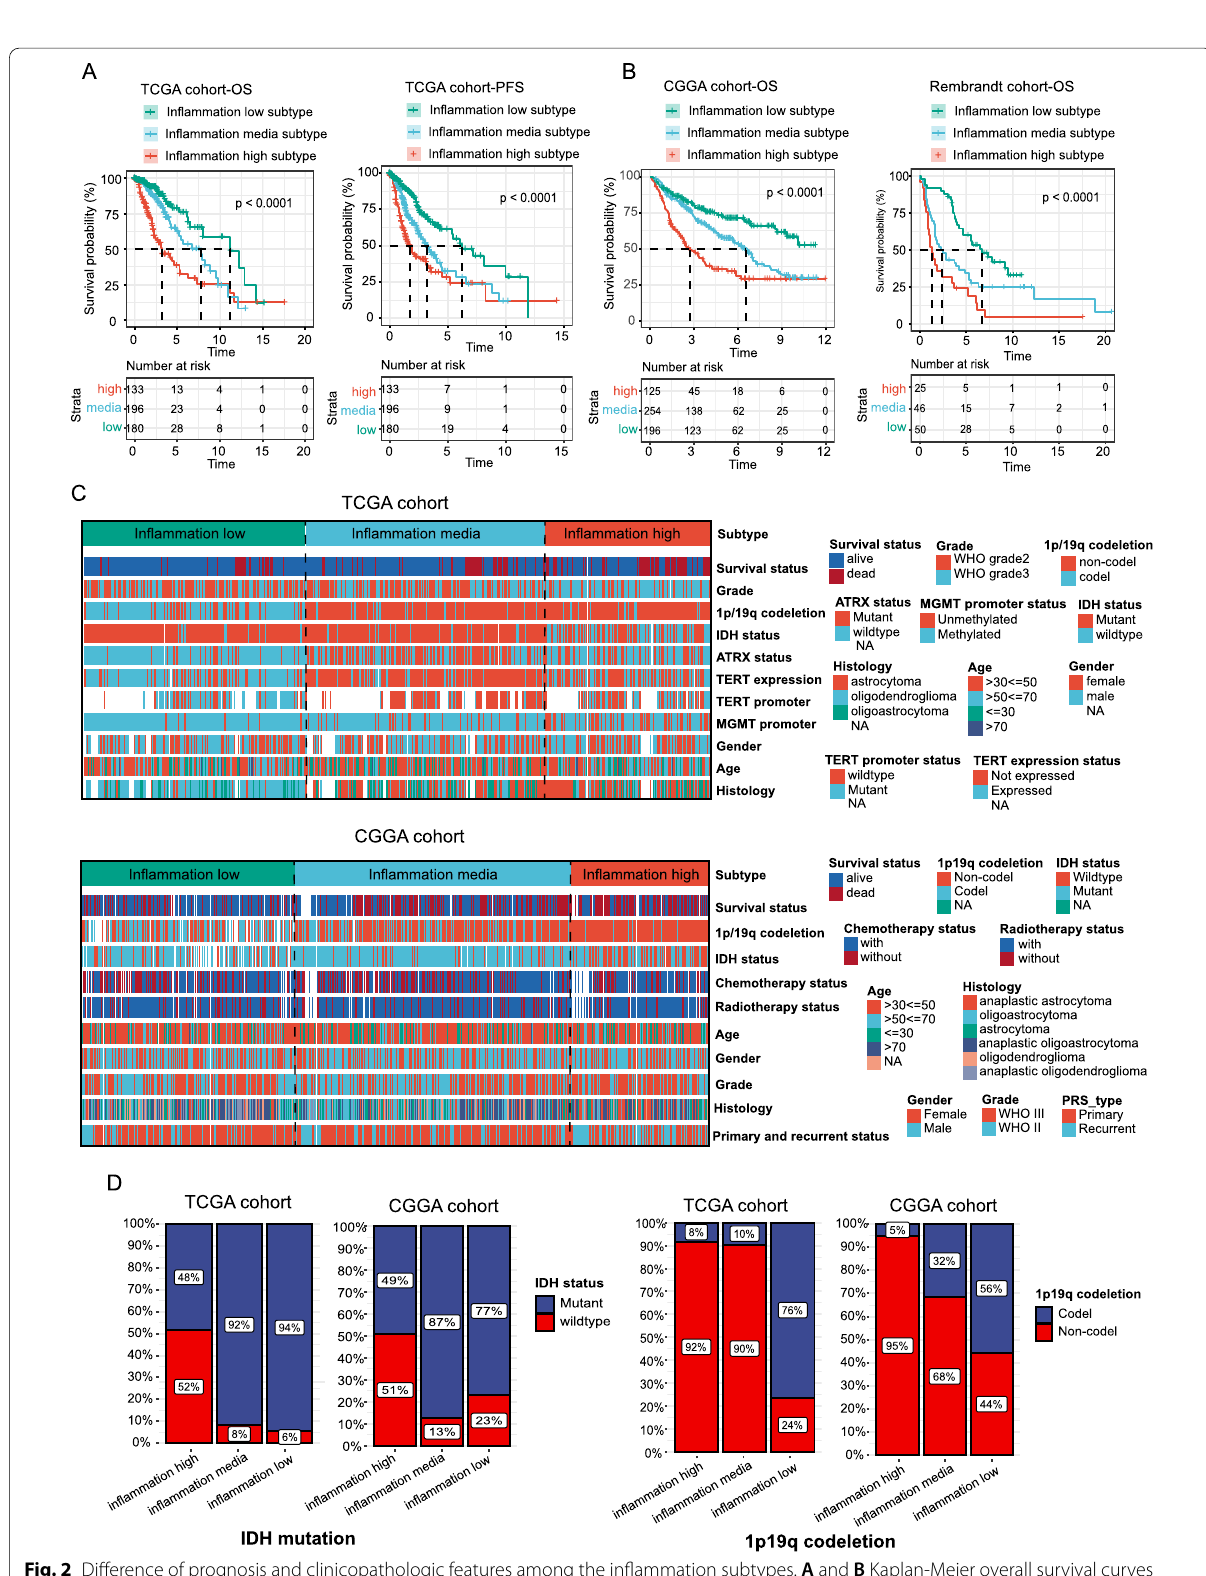
Fig. 2 Difference of prognosis and clinicopathologic features among the inflammation subtypes. A and B Kaplan-Meier overall survival curves for patients assigned into inflammation-low, -mid, and -high subtypes in TCGA ( A ), CGGA, and Rembrandt cohort ( B ). C Heatmap presenting the clinicopathologic features of these subtypes. D 1p19q codeletion and IDH1 mutation frequency among these